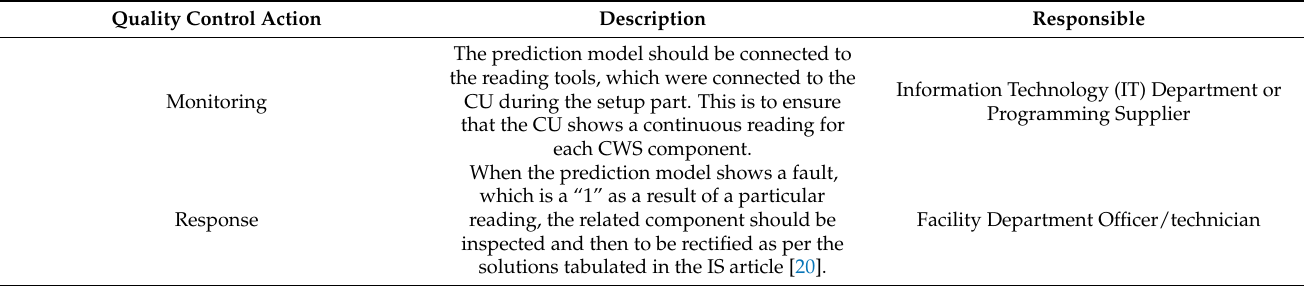
Table 4. Control